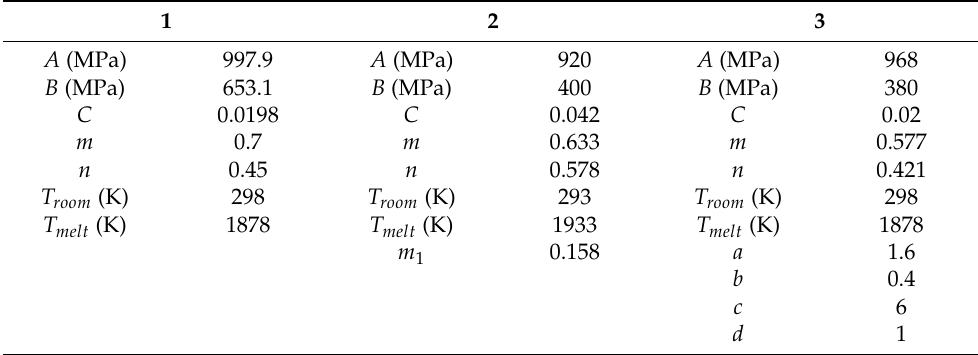
Table 1. Sets of parameters considered for this study—set 1 [31], set 2 [30] and set 3